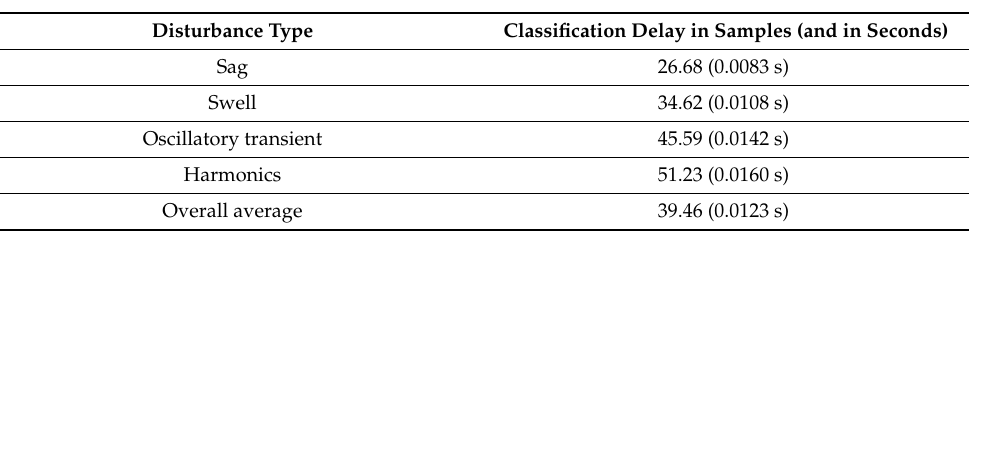
Table 2. The performance of the vector-ODIT in terms of classification delay. The thresholds are set in a way to achieve the maximum classification accuracy and the minimum false alarm